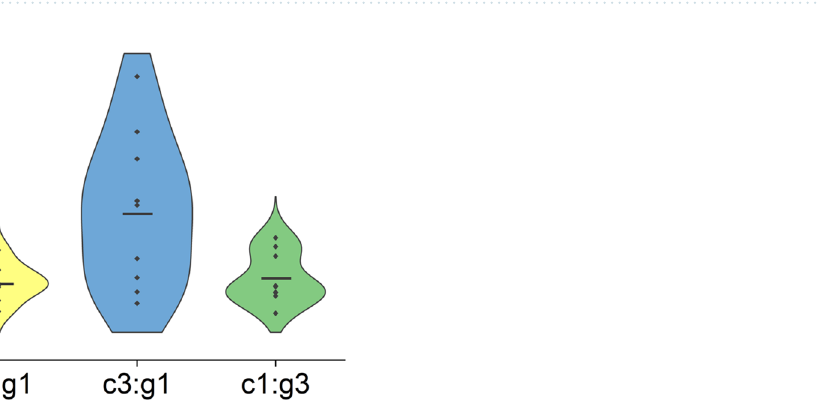
an average peak load of 0.31 N at 20% of strain. Following treatment, the same group of samples only required an average peak load of 0.21 N to reach the same level of compressive strain tested at the same strain rate. Figure 2b shows the average variation of Young’s modulus among the different treatment groups. The elastic modulus data extracted from the indentation tests also resulted in a statistically significant decrease for the c3:g1 treatment group when compared to its control baseline. While the degradative changes to the c1:g1 and c1:g3 groups did not reveal statistical significance (cid:31) p < 0.05 (cid:30) in their biomechanical properties, the cartilage response for all three groups followed a decreasing trend when tested after enzymatic degradation. A similar behavior pattern to the peak load data was observed in the Young’s modulus where the c1:g1, c1:g3, and c3:g1 treatment groups revealed a 19%, 17%, and 33% decrease in elastic modulus, respectively (Fig. 2b). The violin plot in Fig. 3 shows the distributions of differences in elastic modulus (� E ) between healthy and degraded cartilage for the three combinations of enzyme (MMPs) mixtures as a continuous approximation of the probability density function, computed using kernel density estimation (KDE). The width of each curve corresponds with the approximate frequency of data points in each region. Wider sections of the violin plot represent a higher probability, and the skinnier sections represent a lower probability. Distributional differences are displayed in the violin plots, displaying KDE (smoothed histograms) of each dataset. Grubb’s analysis was used to detect significant outliers (cid:31) p < 0.05 (cid:30) before displaying distributional differences in the violin plots of each dataset. Two outliers were detected, one belonging to the c1:g1 treatment group and one belonging to the c1:g3 treatment group. No significant outliers were detected in the c3:g1 treatment group. The outliers were excluded from the results before analyzing the distribution. It is apparent that the distribution of (cid:31) E for the activity of c1:g3 is bimodal, while c1:g1 and c3:g1 are unimodal. Pairwise distributions of Young’s modulus ( E ) between the control and each treatment group are also shown via violin plots (see Supplementary Fig. S1 online) and data can be found in Supplementary Table S1 online. Both the mechanical properties, stiffness and peak load, were statistically analyzed. Statistical analysis by the Kruskal–Wallis test (cid:31) p < 0.05 (cid:30) showed that the stiffness as well as peak load at 20% strain resulting from the indentation tests on the c3:g1 treated cartilage were significantly different at the α = 0.05 level of significance.